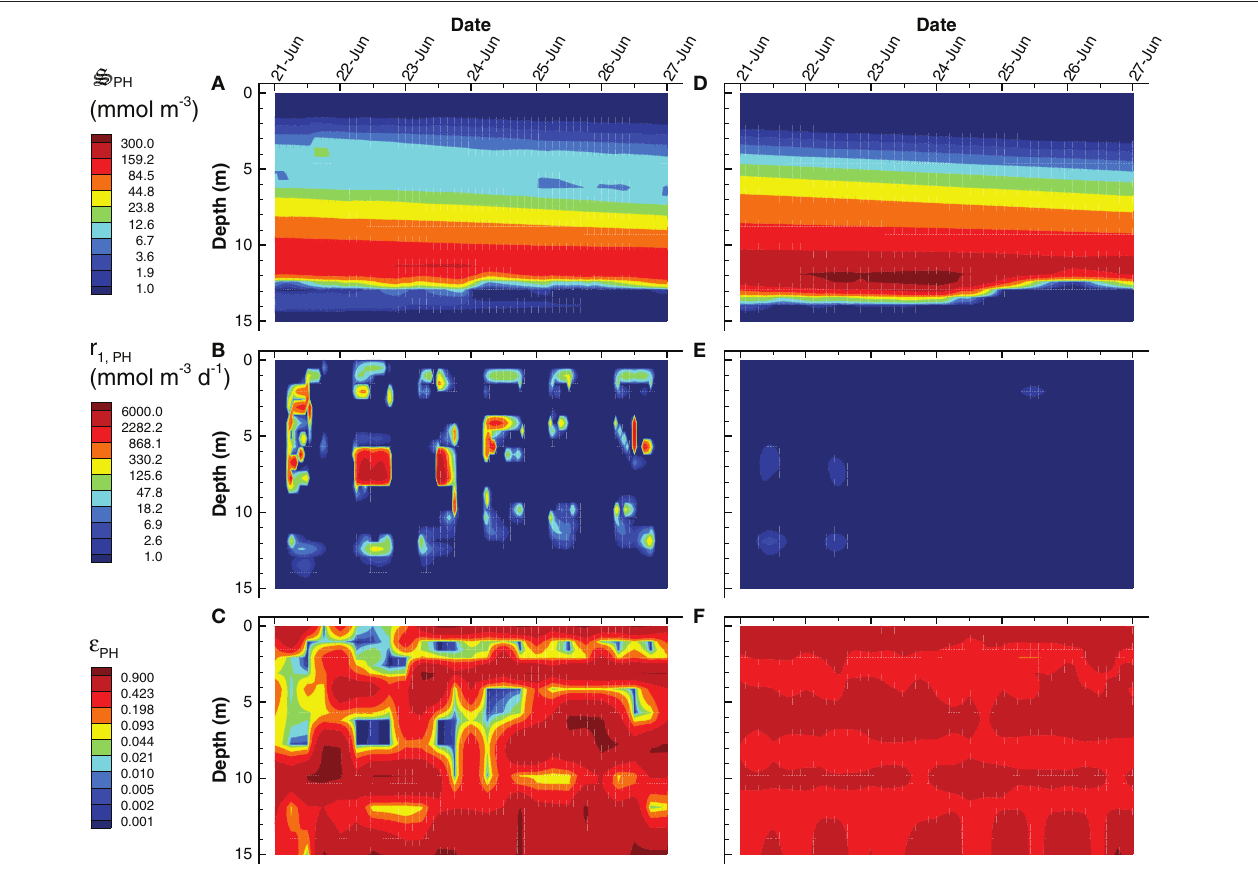
FIGURE 10 | Contour plots of photoheterotroph concentration, [ S PH ] (A,D) , rate of the carbon fixation reaction, r 1, PH (B,E) and the growth efficiency optimal control variable, ε PH (C,F) for the SIO (A–C) and LIO (D–F) simulations. Note, contours for ε PH were selected to emphasize ε PH values near